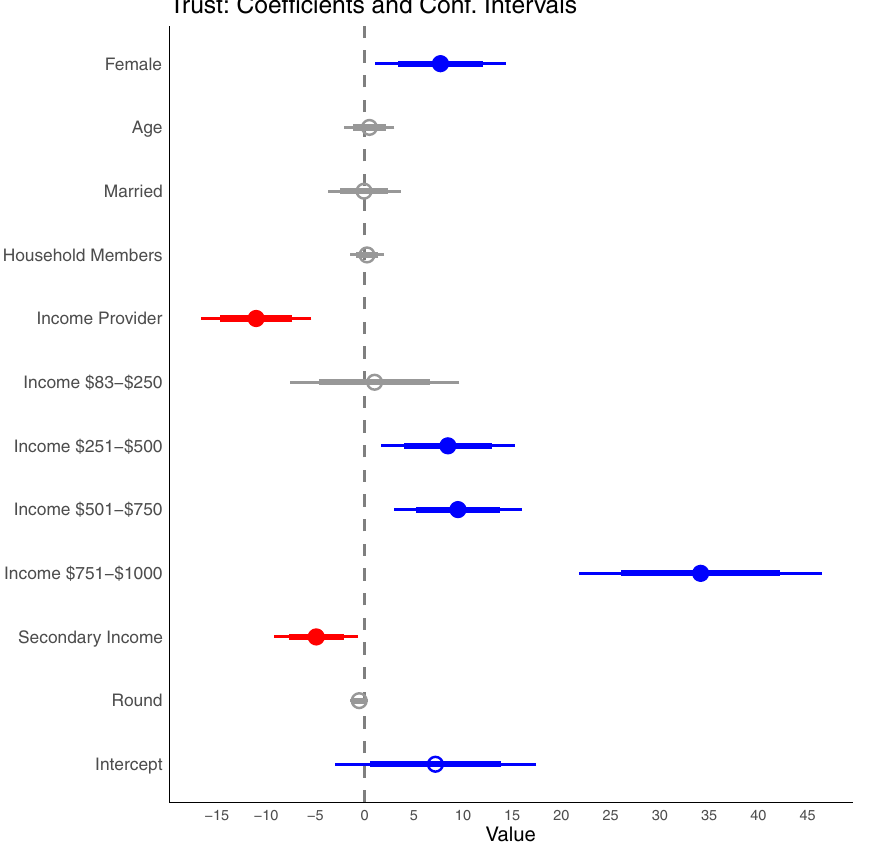
Figure 3. Coefficient plot of how the amount sent by senders (Trust) is related to gender, age, marital status, number of household members, whether a subject was the income provider, the levels of monthly income, whether the subject had a secondary non-fishing income, and the round number. Thick lines represent 80% confidence interval, while thin lines are 95% confidence